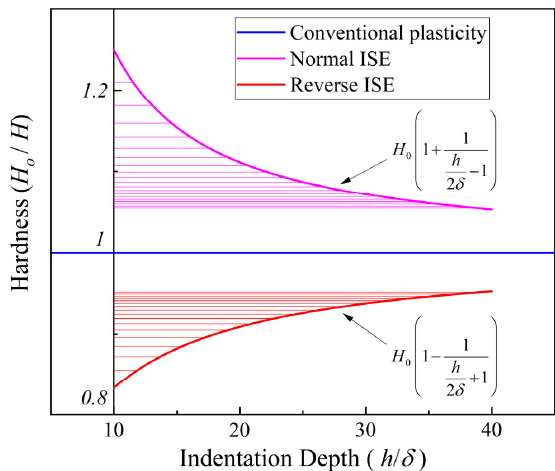
Figure 4. An analytical model about ISE incorporating surface defect and indenter tip irregularity. The normal ISE can model the effect of groove defect effect and tip bluntness, while the effect of convex defect and tip sharpness is expressed by the reverse ISE.